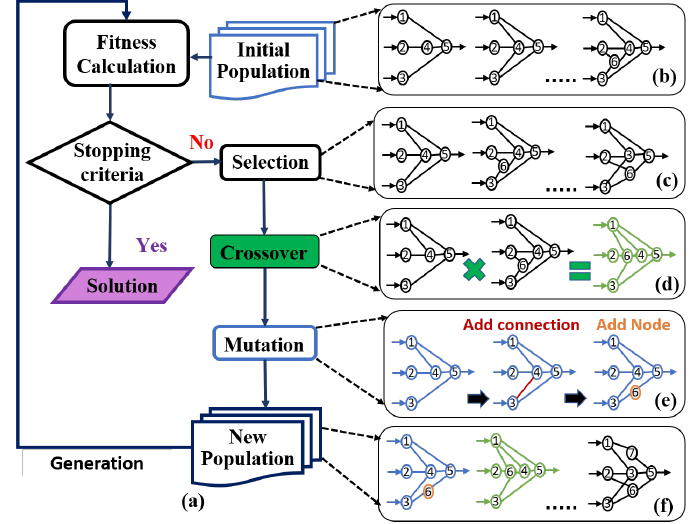
Figure 3: A general overview of the evolution mechanism involved in NEAT, and conse- quently, InfoNEAT. Note the multi branches and skip connections that have been used in step (e). Note that the population depicted here includes only one